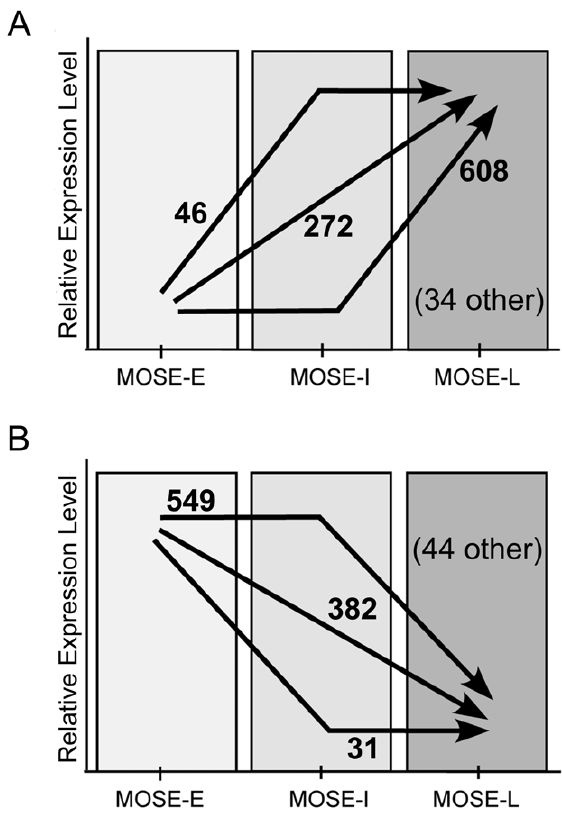
Figure 1. Gene expression changes during progression of MOSE cells. Of 45,102 probe sets analyzed, 970 were significantly (p # 0.05) up-regulated ( A ) and 1006 were down-regulated ( B ) greater than two fold. Arrows indicate pattern of expression changes with number of probe sets indicated next to the arrow. Probe sets indicated as other did not follow the described patterns.